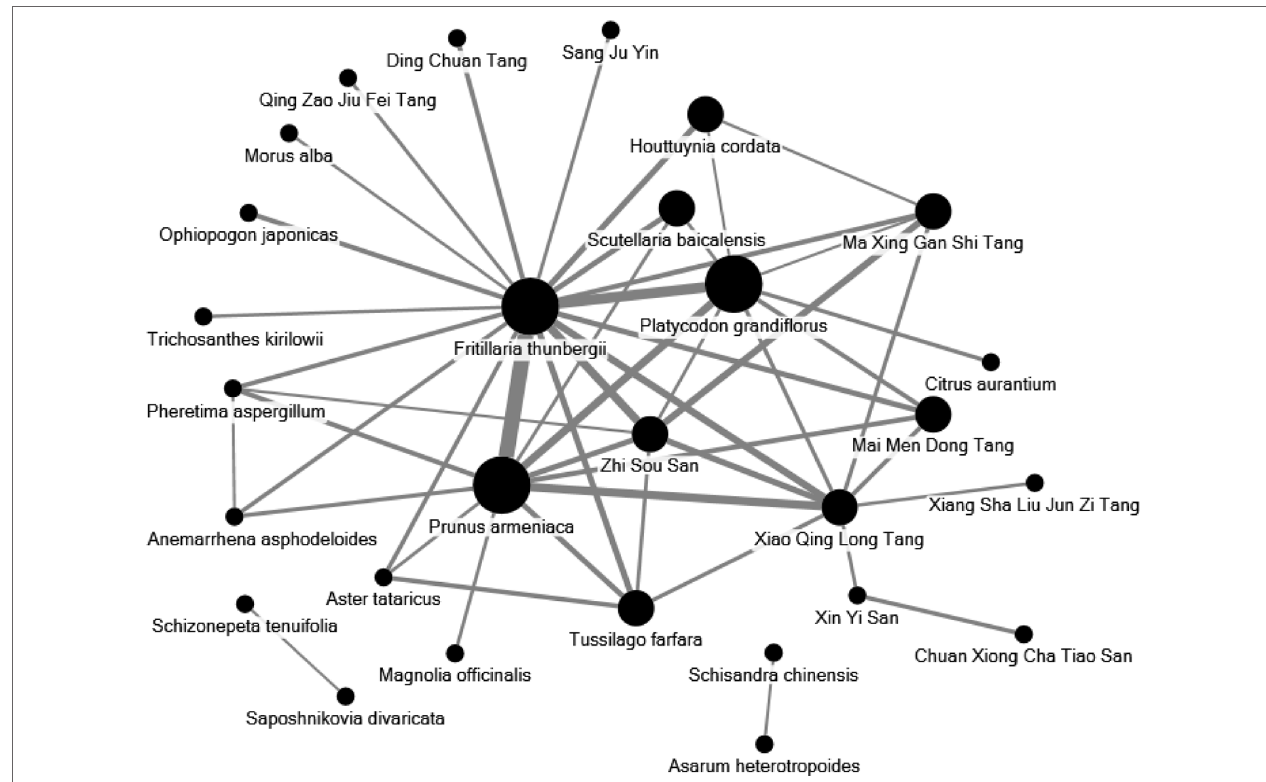
FIGURE 4 | Network analyses of the most frequent 30 herbs and formulas combinations for all patients with COPD. The size of spot indicates the frequency of Chinese herbal product and the width of line indicates the combination time of two Chinese herbal